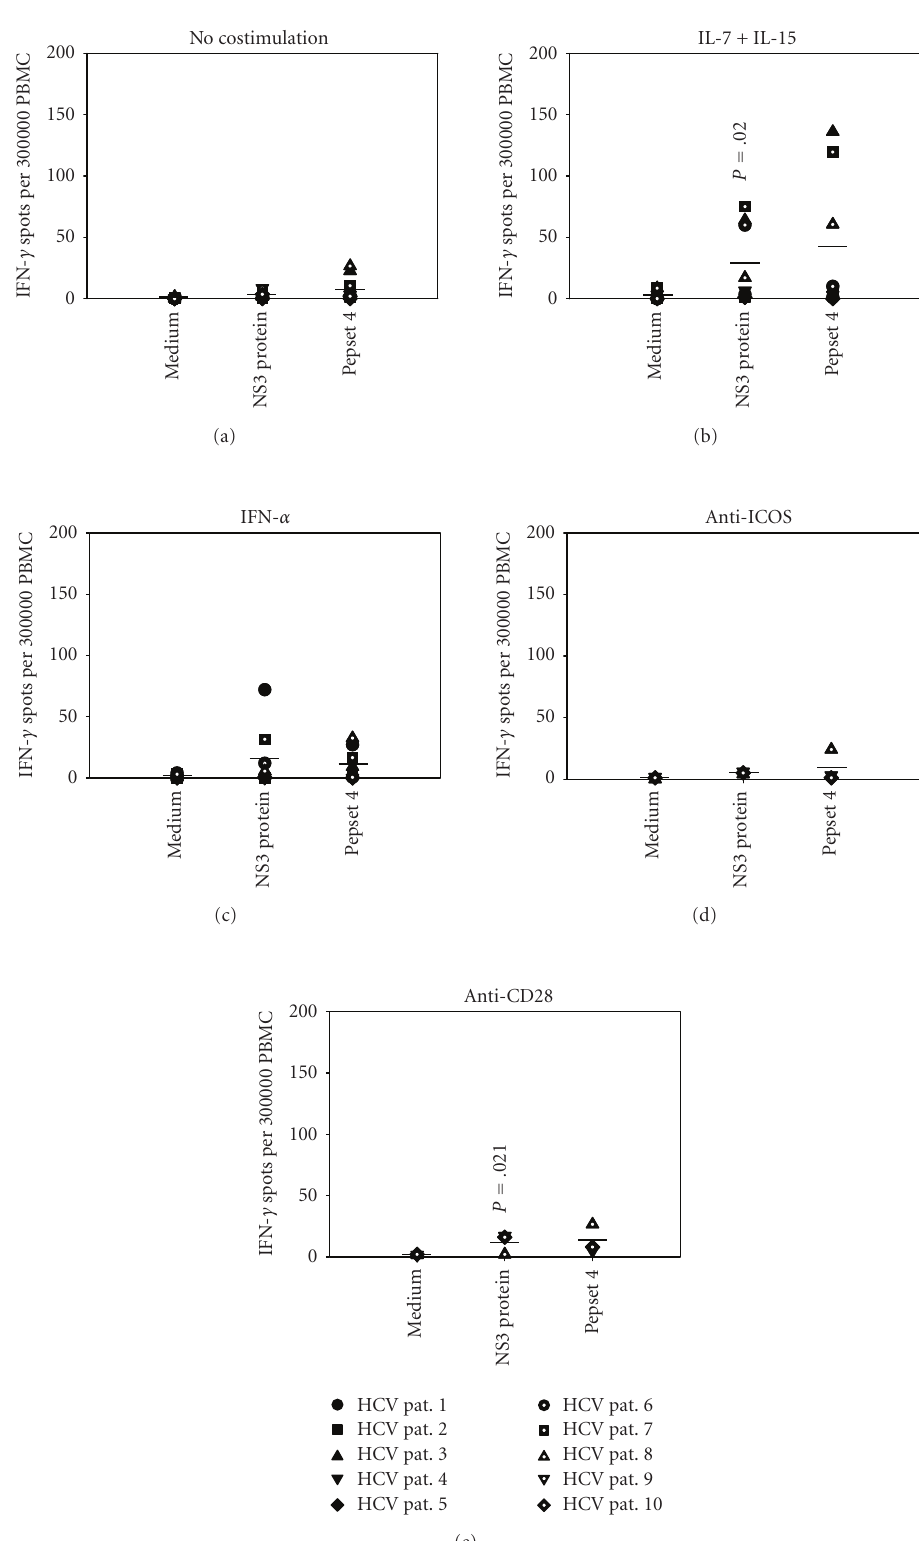
Figure 1: Increased responses to NS3 protein in HCV-infected patients only after in vitro costimulation with IL-7/IL-15 or anti-CD28. PBMCs of 10 HCV-infected patients were tested in IFN- γ ELISPOT assays for their recall responses to NS3 protein and Pepset 4 peptide pool in the absence (a) or presence of IL-7/IL-15 (b), IFN- α (c), anti-ICOS (d), or CD28 (e). For each individual, the mean spot count of duplicate wells is shown. Horizontal bars indicate the means of all individual responses to the respective antigens. P values are given for means that are significantly di ff erent from baseline values in (a). Symbols in (a) also apply to